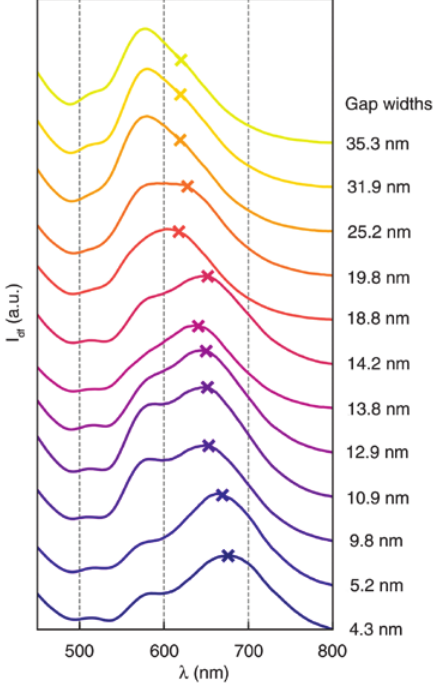
Figure 8: Dark-field spectra of single dimers with different interpar- ticle spacings. As the gap width decreases from top to bottom, a strong red-shift of the bonding dipolar mode is visible. The crosses denote the reso- nant wavelength of the bonding dipolar mode. The spectra are nor- malized and vertically offset for clarity. SEM images of the individual dimers can be found in the Supporting Information Figure S3.